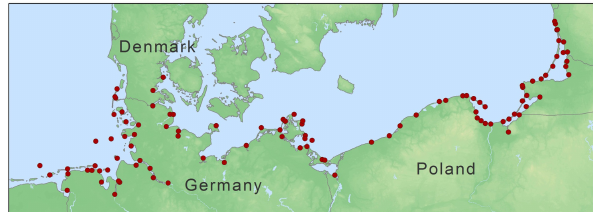
Figure 9. Positions of signal stations of the German Naval Obser- vatory Hamburg